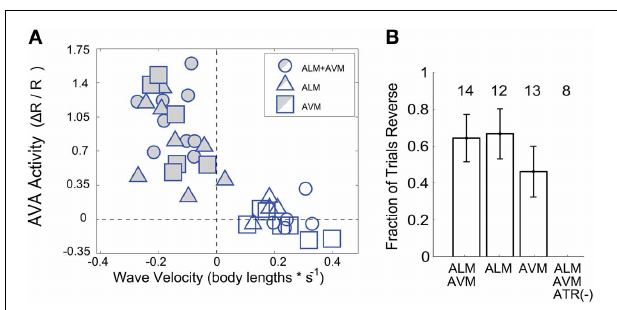
FIGURE 4 | (A) For each trial, the amplitude of AVA activity is plotted against the within-trial mean velocity during a trial-specific time window, ( n = 39 trials). Both reversers (shaded points) and non-reversers (open points) are included. (B) The fraction, f , of worms that respond by reversing (reversers) are shown for each stimuli. Number, n , indicates total trials. Control worms grown without the ChR2 co-factor all-trans retinal (ATR ( − )) (cid:2) f ( 1 − f )/ n , where f is are also shown. Error bars are standard error, σ f = the fraction of worms that reverse out of a total, n